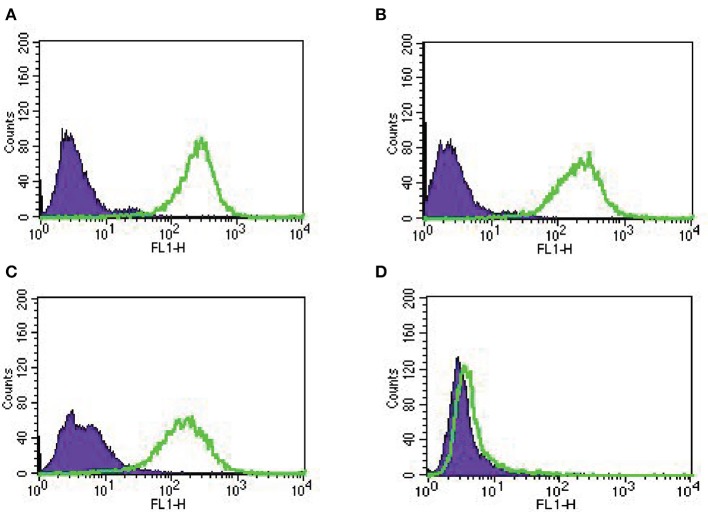
Representative Trop-2 expression by flow cytometry histograms of primary EOC cell lines, (A) KRCH31, (B) OVA1 and (C) OVA10 3+ Trop-2 expression, (D) OVA14 0 Trop-2 expression.